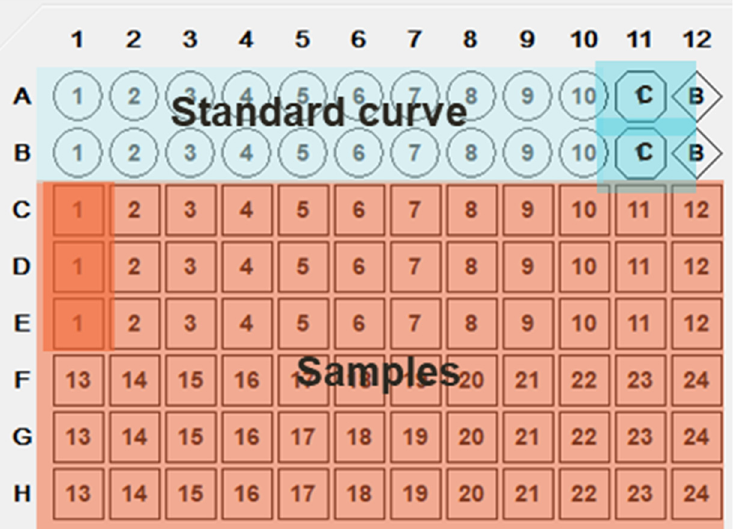
Figure A4. Suggested 96 well plate layout for testing of clinical samples in future human vaccine trials and seroepidemiological studies. C = positive control, B = blanks.